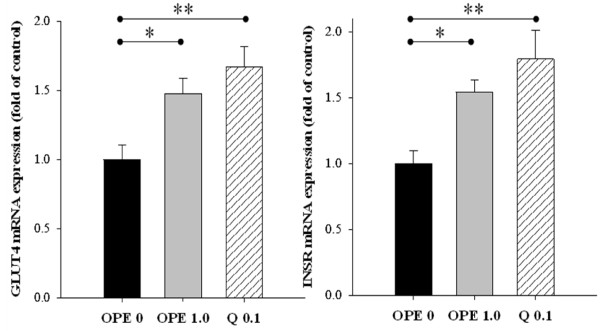
Effects of OPE or quercetin on the mRNA expression of the INSR and GLUT 4 in skeletal muscle of HFD/STZ-induced diabetic rats. Expression levels for INSR and GLUT4 were determined by quantitative RT-PCR, normalized against β-actin, and plotted relative to those of diabetic control rats. Data are expressed as means ± SE (n = 7 for each group). Comparisons were done between the control group and each individual treated group by Dunnet's multiple comparison test. *Different from control, P < 0.05, **different from control, P < 0.01